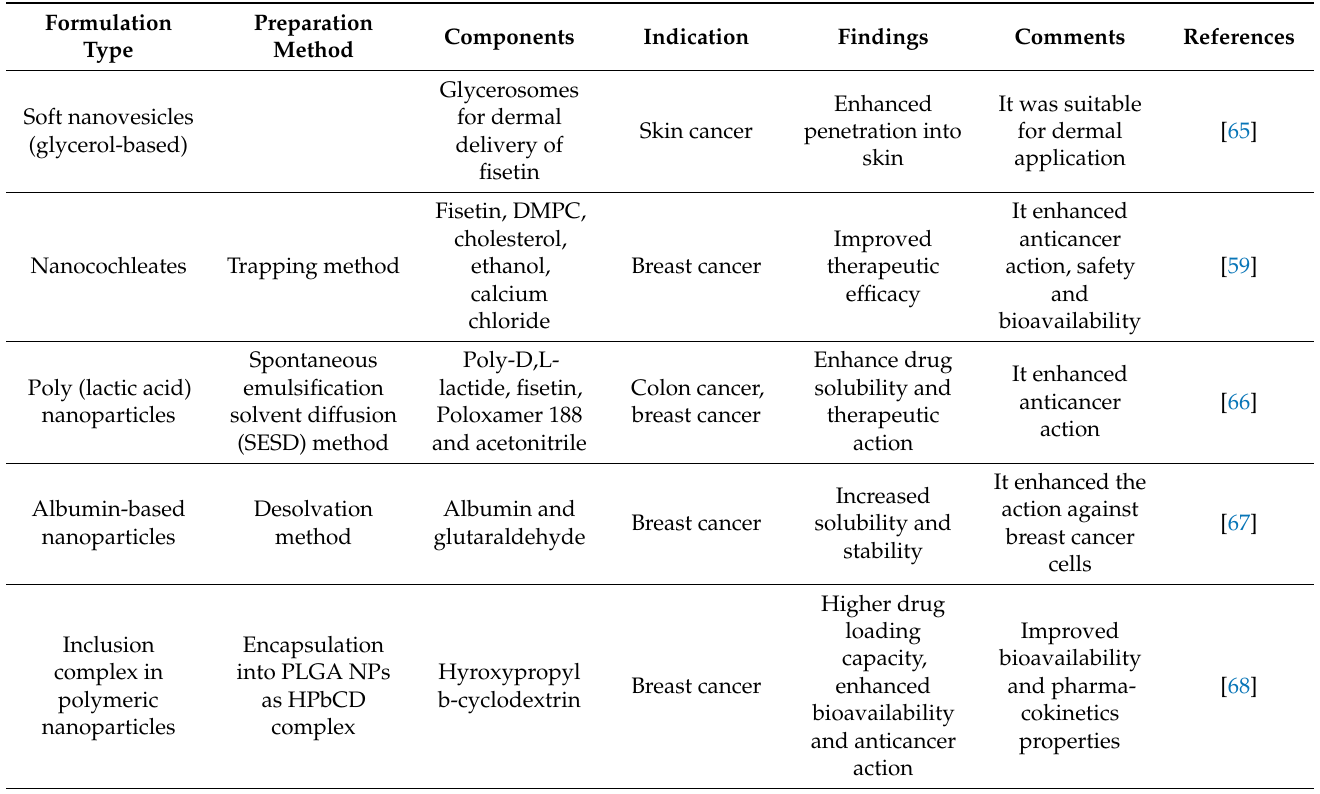
Figure 5. Delivery strategies used to improve fisetin performance. Adapted from [64]. Copyright © 2018 Elsevier Masson SAS. Table 2. Fisetin-based formulations developed using novel strategies.